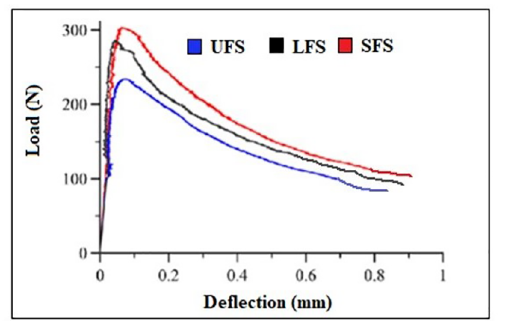
Figure 6. Fatigue load and deflection of composite spring From the cyclic load-deflection plot, energy dissipation of check leaf spring is classified. The energy depravity